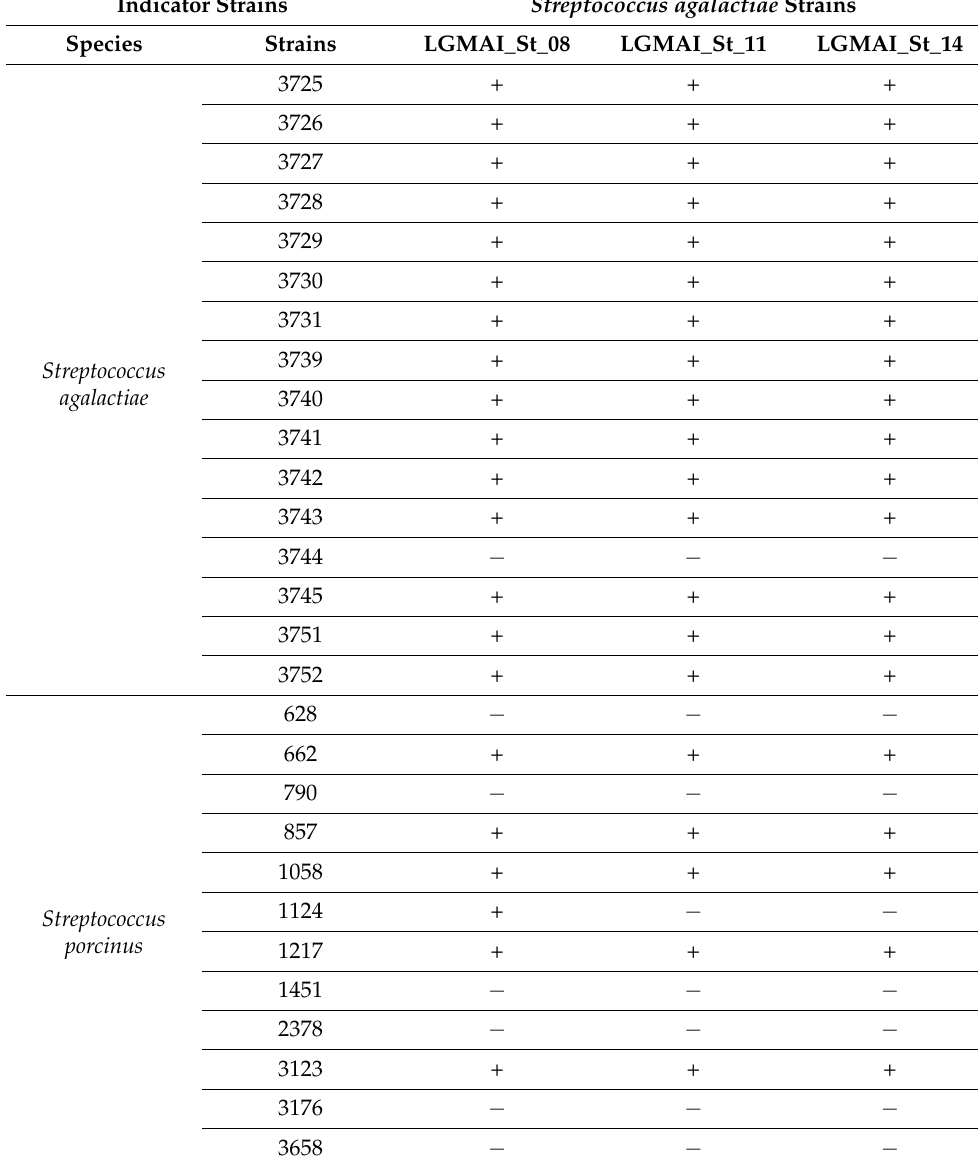
Table 6. Additional deferred growth inhibition assays results. Additional tests were performed with strains LGMAI_St_08 (3772), LGMAI_St_11 (3800), and LGMAI_St_14 (3799). (+) indicates clear inhibition zones of at least 2 mm in size; ( − ) indicates absence of